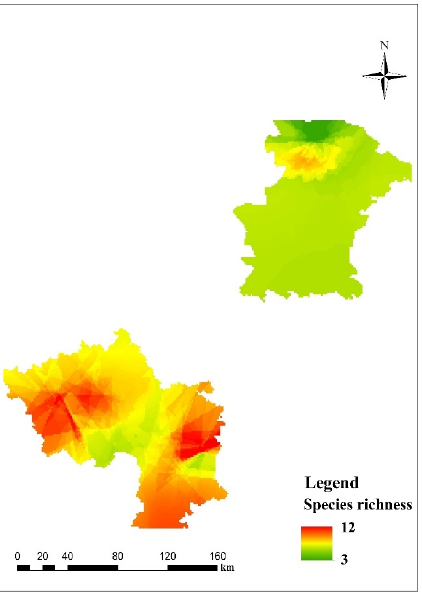
Figure 3. Predictive beetle richness for the study area. Red colors correspond to areas predicted to be species rich, while yellow and green colors correspond to areas predicted to harbor intermediate and low levels of richness.